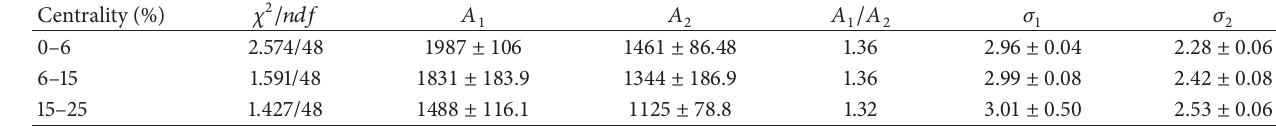
Table 3: PHOBOS Au+Au 200 GeV.